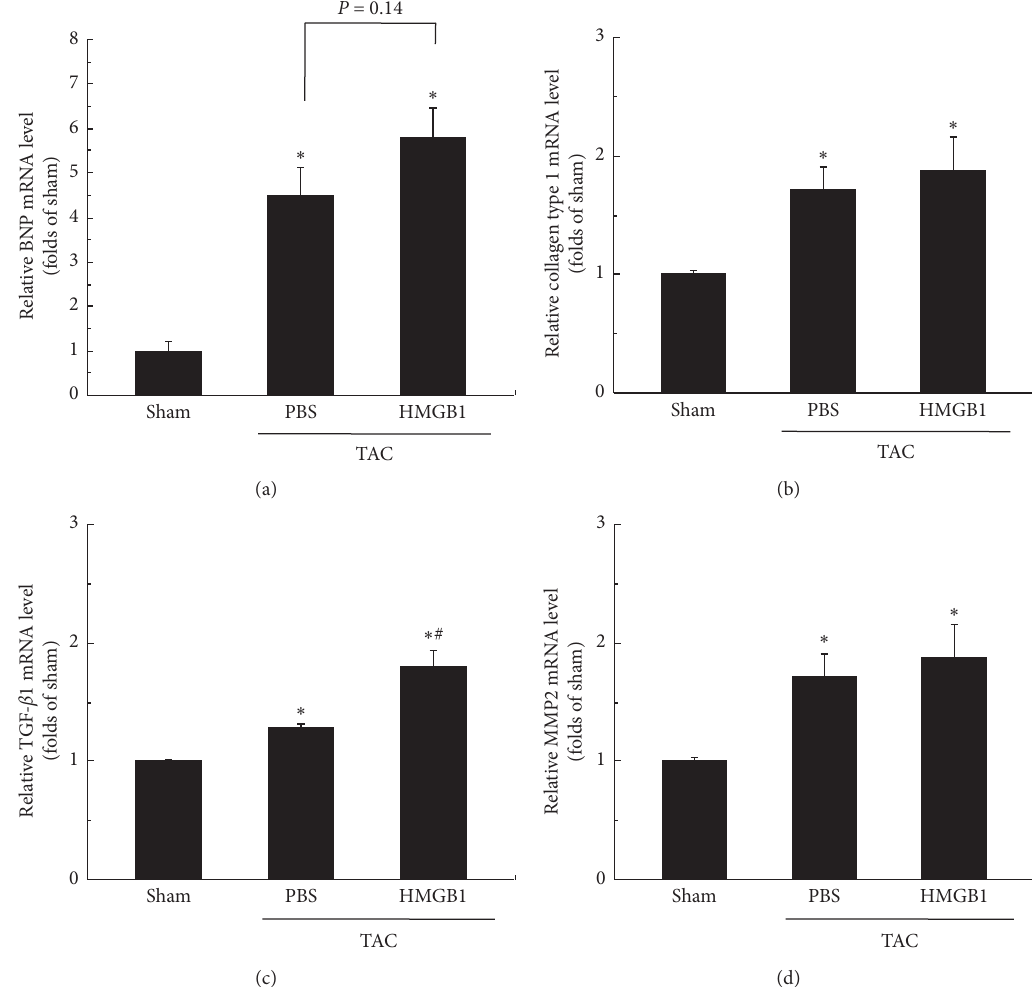
Figure 5: Quantitative real-Time PCR analysis of relevant mRNA expression in the myocardium at 4 weeks after intervention. TAC: transverse aortic constriction; HMGB1: high-mobility group box 1; BNP: brain natriuretic peptide. Data are represented as mean ± S.E.M. n > 8 per group in each group. ∗ P < 0 . 05 versus the sham group; # P < 0 . 05 versus the respective TAC +PBS